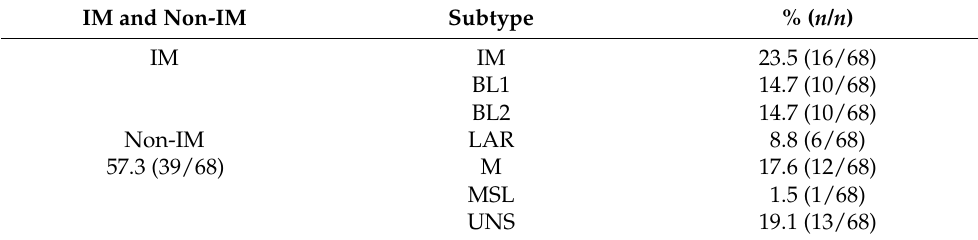
Table 2. Molecular Subtype by Lehmann et al. [4]. IM and